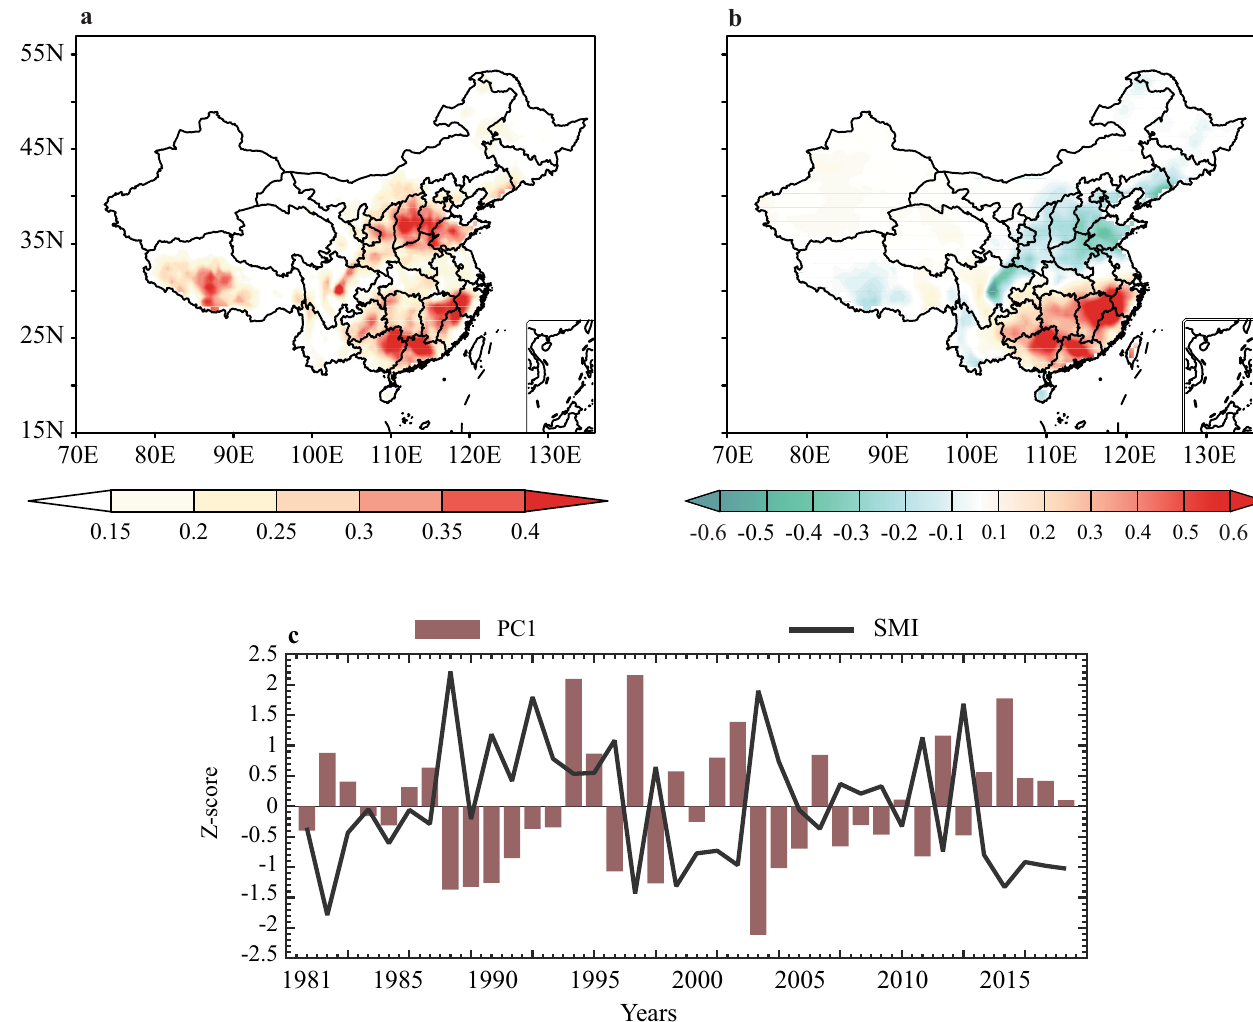
Fig. 2 The SM forced precipitation variance ratio meridional variability. The a fraction of EAM (JJA) precipitation (unit: mm) forced by JJA SM (unit: m 3 m − 3 ), the b eigenvectors of the forced precipitation leading mode, and the c PC1 and SMI during 1981 – 2018. The forced precipitation leading mode variance is 63%, whereas the PC1 and SMI are negatively correlated ( − 0.62) with a signi fi cance bound of